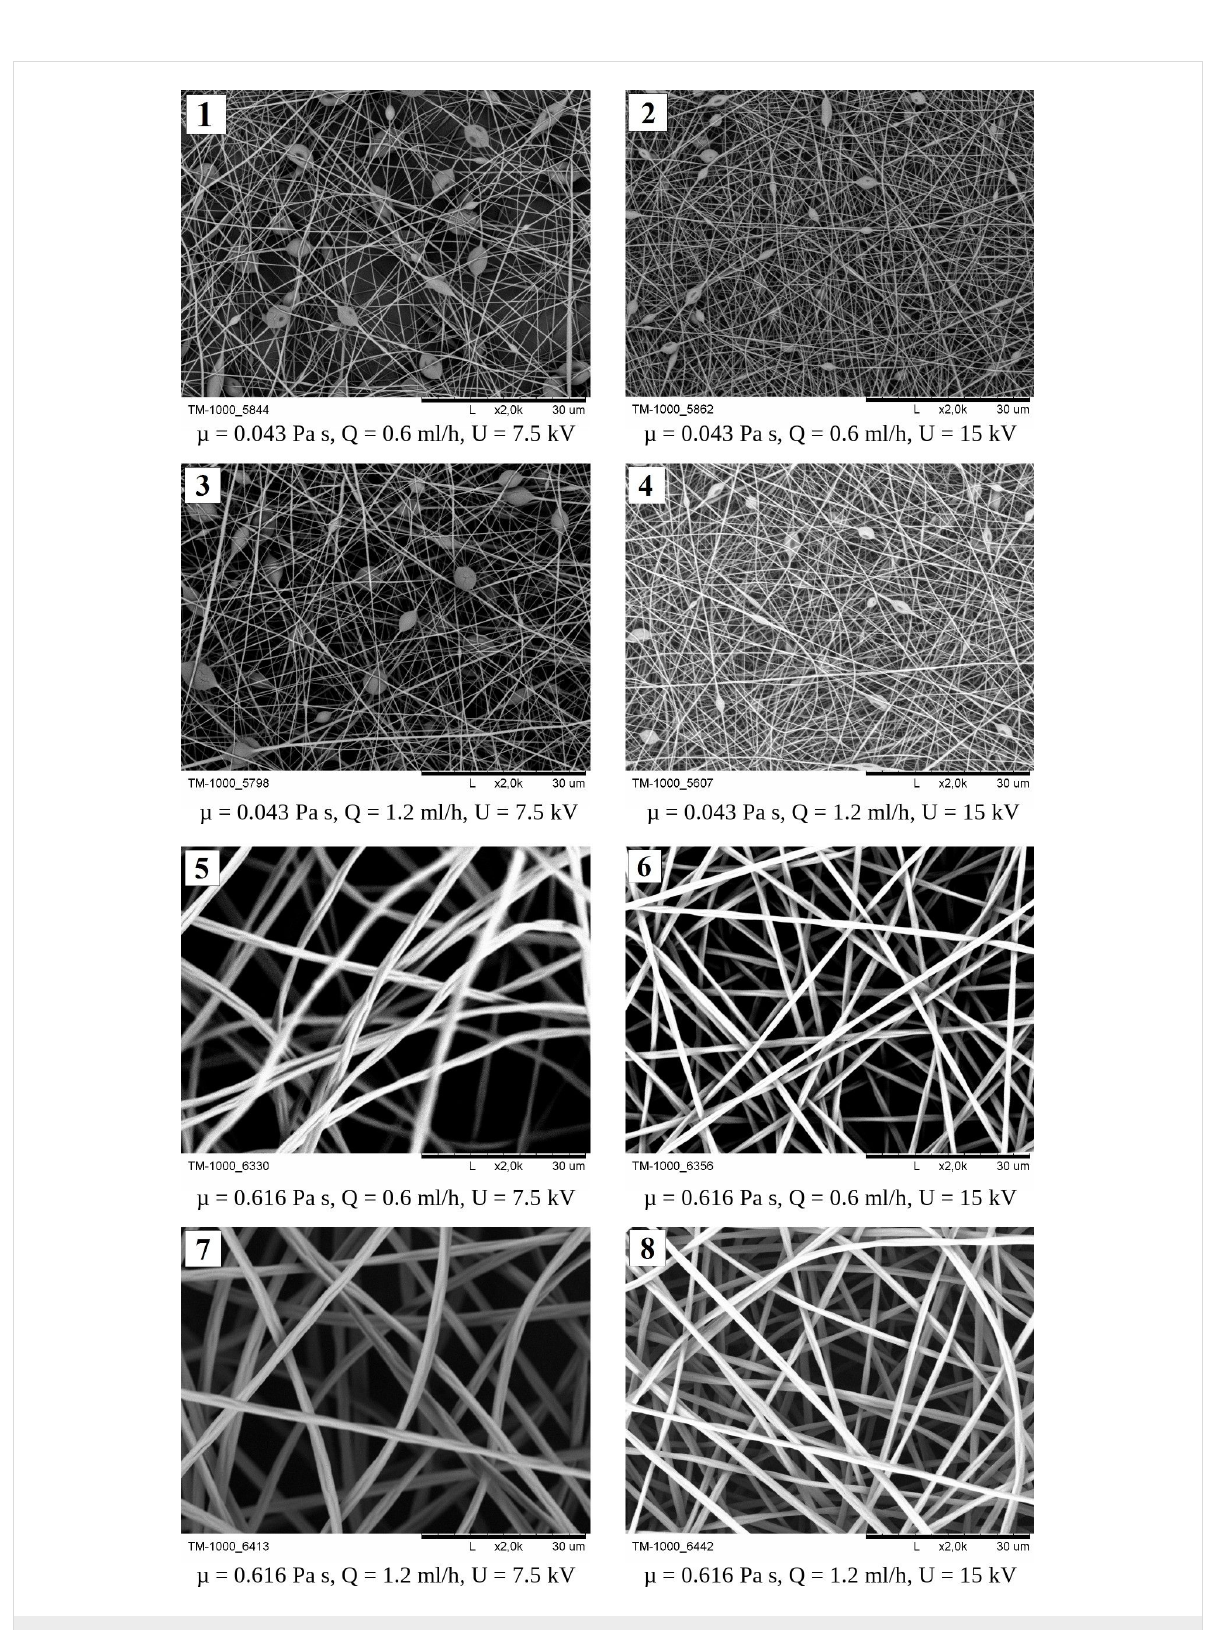
Figure 4: SEM micrographs of nanofibers obtained under various conditions: (1) PVP 8% (µ − , Q − , U − ); (2) PVP 8% (µ − , Q − , U +); (3) PVP 8% (µ − , Q +, U − ); (4) PVP 8% (µ − , Q +, U +); (5) PVP 20% (µ+, Q − , U − ); (6) PVP 20% (µ+, Q − , U +); (7) PVP 20% (µ+, Q +, U − ); (8) PVP 20% (µ+, Q +, U +), where “+” indicates the high level of the given factor and “ − “ the low level of the given factor. The black scale bar underneath all images is 30 μ